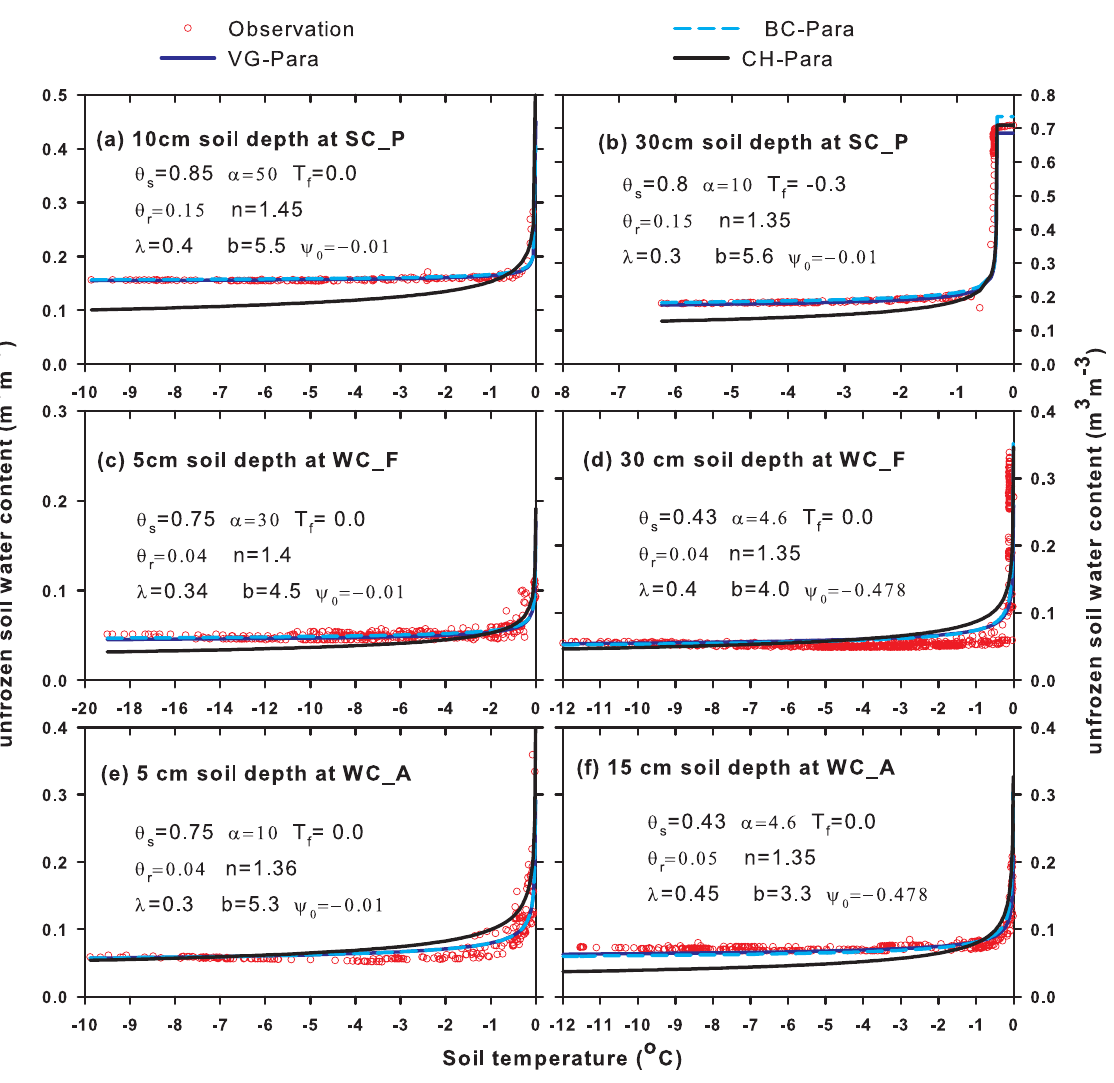
Fig. 3. Observed unfrozen water–soil temperature relationships at the three sites and parameterisations with Eq. (20) and three soil water retention parameterisations. Panel (a) , (b) , (c) and (e) are organic soils and (d) and (f) are mineral